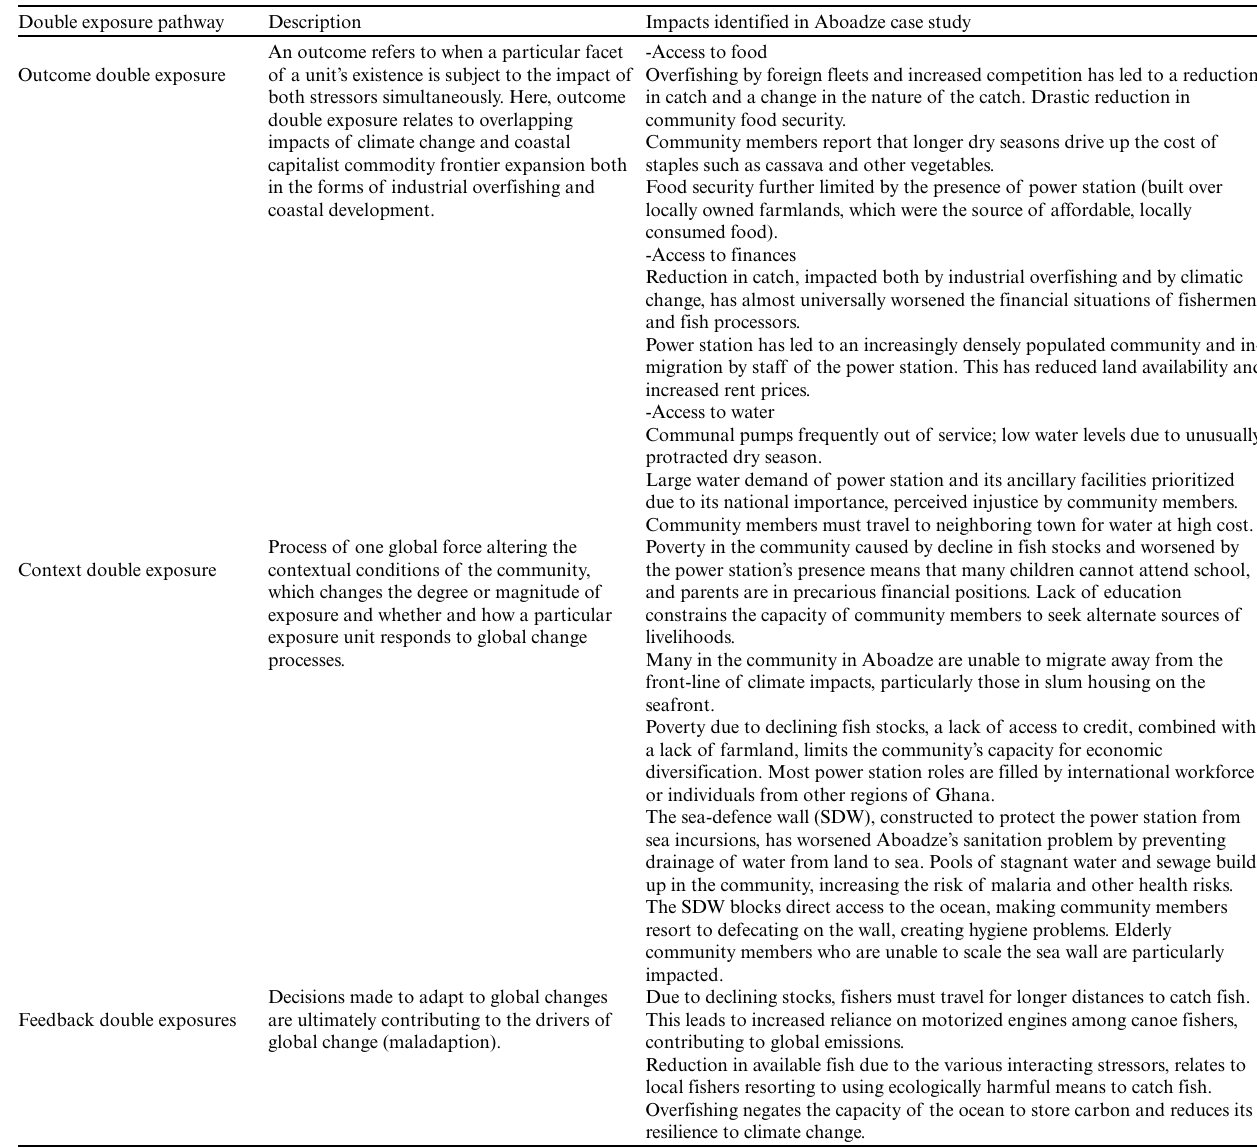
Table 1 . Summary of the